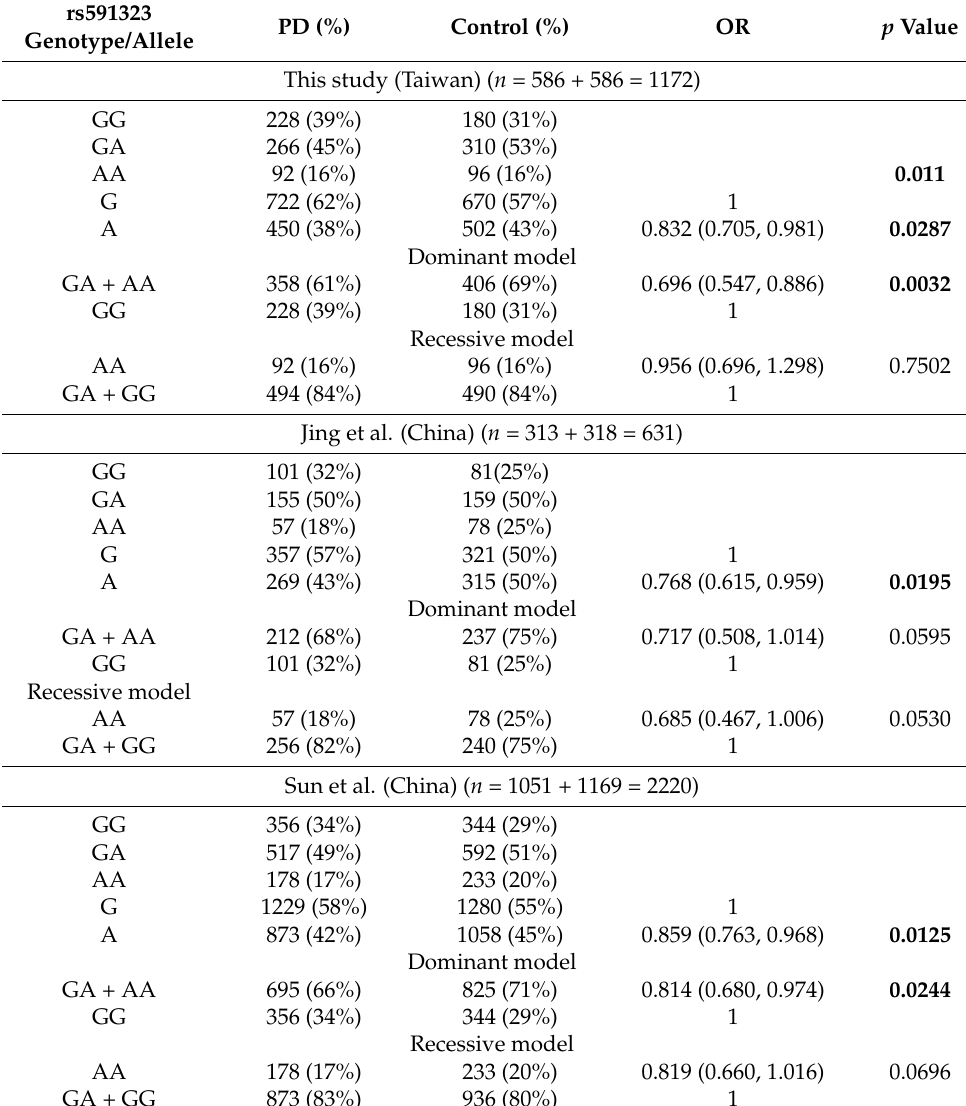
Table 2. Summary of the three studies included in the